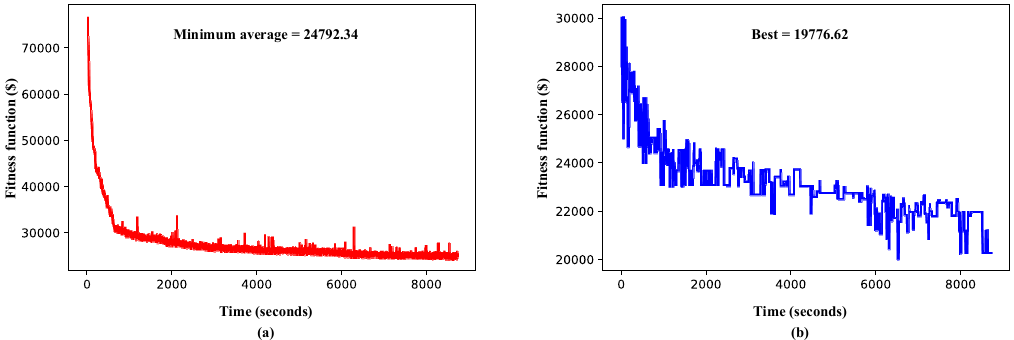
Fig. 8. (a) The change of the average fitness function of the HGA-VNS with time for the fast demand fulfillment, (b) The change of the best fitness function of the HGA-VNS with time for the fast demand fulfillment As seen in Table 11, the best objective function was obtained with the HGA-VNS algorithm. The routes that were found in the HGA-VNS algorithm to fulfill the fast demand were shown in Fig. 9.